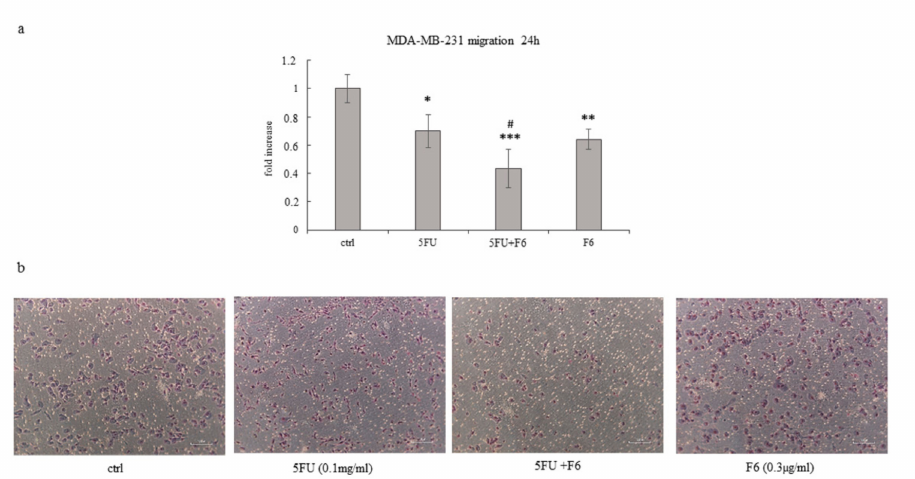
Figure 4. Effect of 5FU, 5FU + F6, and F6 on migration in MDA-MB-231 cells. Transwell migration assay ( a , b ) was performed in MDA-MB-231 cells untreated (ctrl) and treated with 5FU, 5FU + F6, and F6 for 24 h. Values, expressed as fold increase of control value considered as 1, are means of three independent experiments performed in duplicate, with SD represented by vertical bars. * p < 0.05; ** p < 0.01; *** p < 0.001 versus ctrl; # p < 0.05 versus 5FU by ANOVA followed by Bonferroni post-test. Images were obtained by optical microscopy, with 100 ×